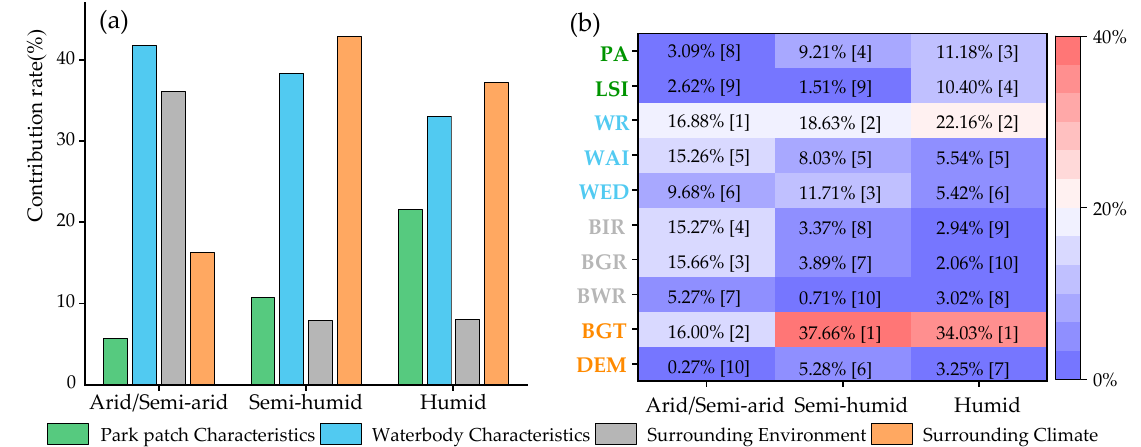
Figure 6. Contribution rate of influencing factors of park cooling intensity: ( a ) is the total contribution rate of the four categories, ( b ) is the individual contribution rate of 10 impact factors, [] is the importance ranking of impact factors.